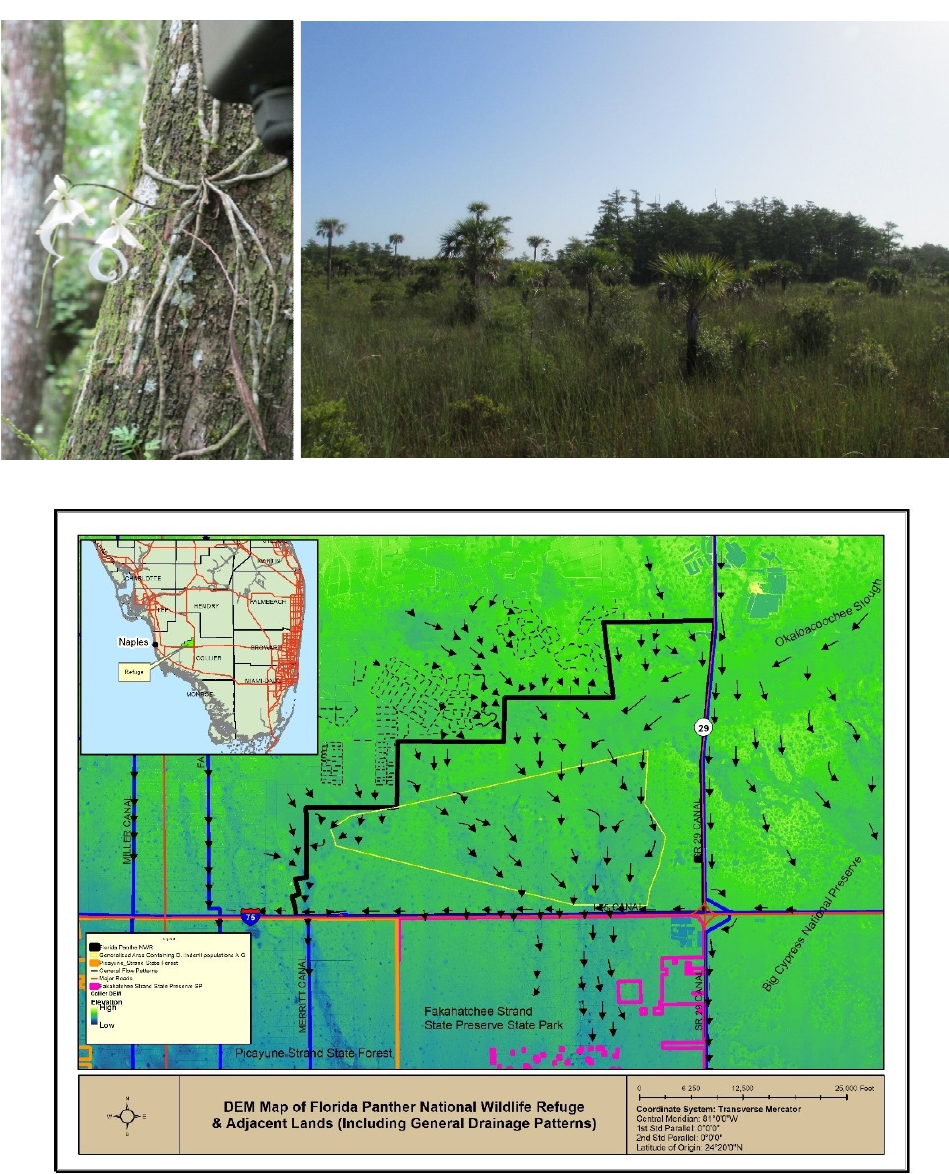
Figure 1. Left: Dendrophylax lindenii within the Florida Panther National Wildlife Refuge (FPNWR). Photo by M. Danaher. Right: The habitat of Dendrophylax lindenii within the Florida Panther National Wildlife Refuge showing an isolated cypress dome (background) where hydrology is conducive to supporting this species and other epiphytic orchids. The dome is surrounded by wetland prairie habitat dominated by sawgrass and frequented by cabbage palms ( Sabal palmetto ). Photo by L. Zettler. Bottom: Map of south Florida, USA showing the location of the study site (FPNWR). Most of the estimated 2000 remaining ghost orchids are confined to this region, especially within the FPNWR and Fakahatchee Strand Preserve State Park to the south.